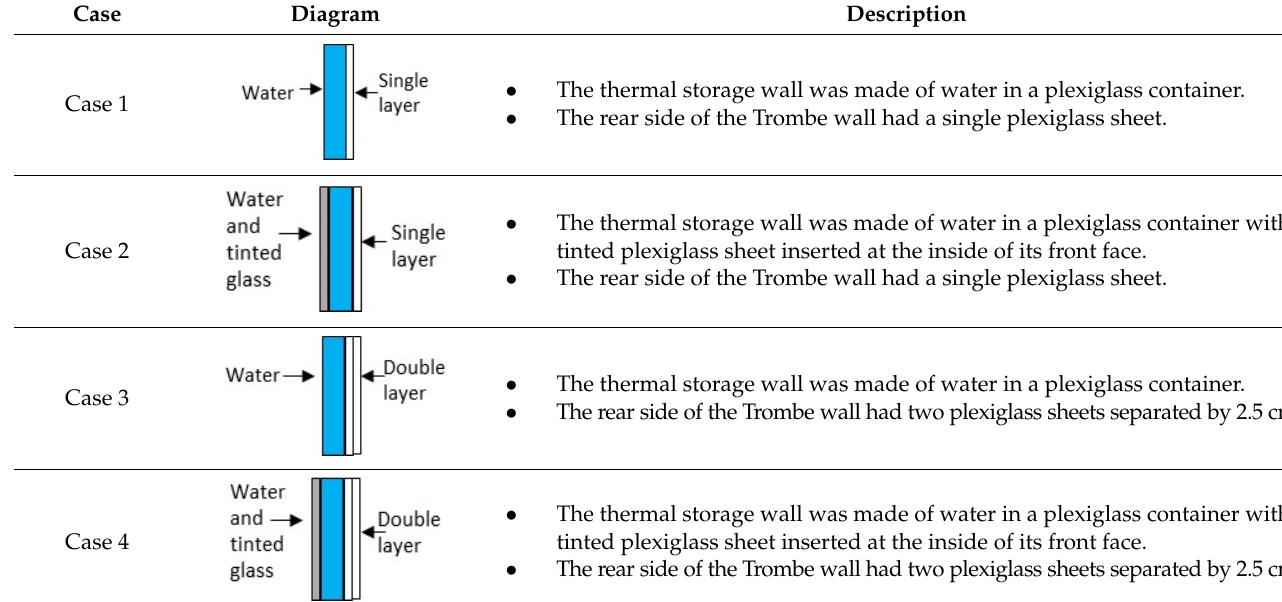
Figure 3. Schematic of the experimental setup showing the location of the thermocouples inside the water storage medium. Table 1. The thermal storage wall designs experimentally investigated in this work. Table 1. The thermal storage wall designs experimentally investigated in this